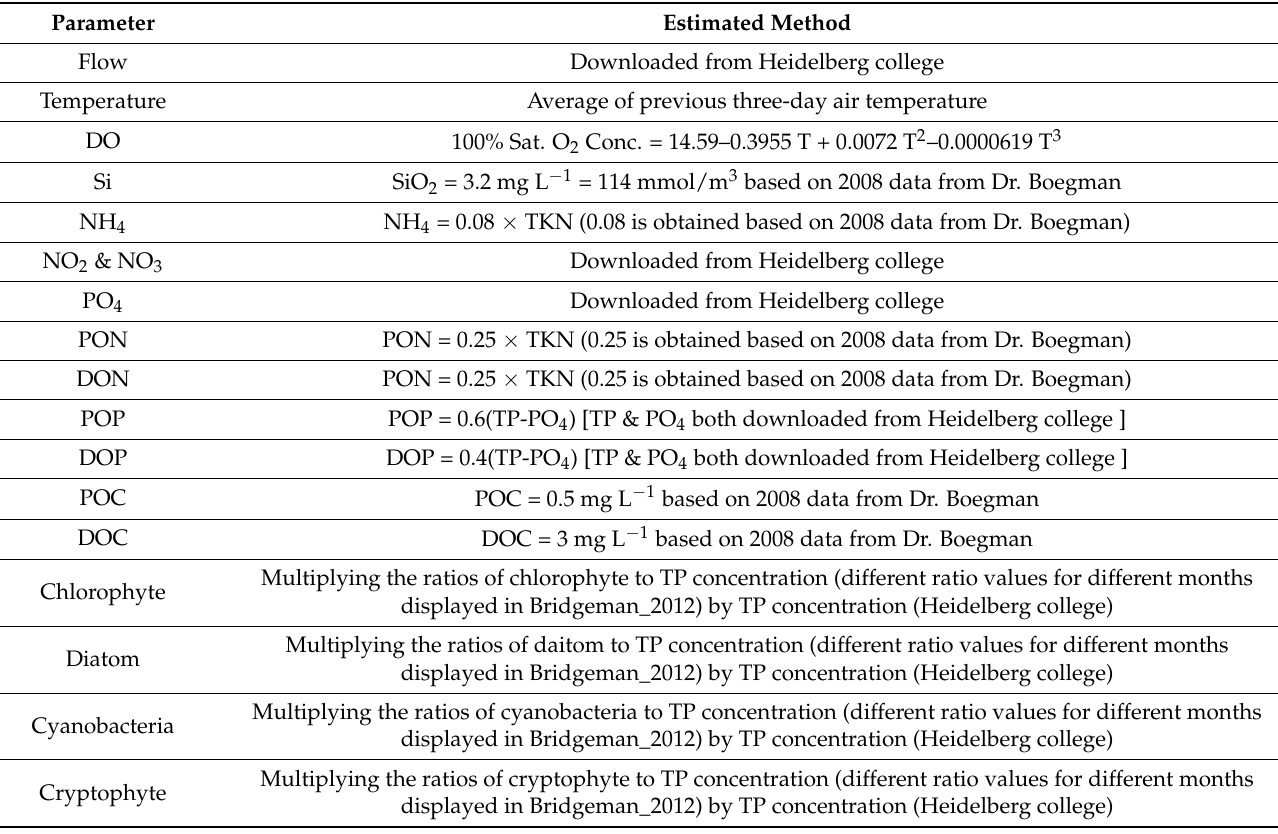
Table A2. Summary of Water Quality Data Sources of the Maumee River.